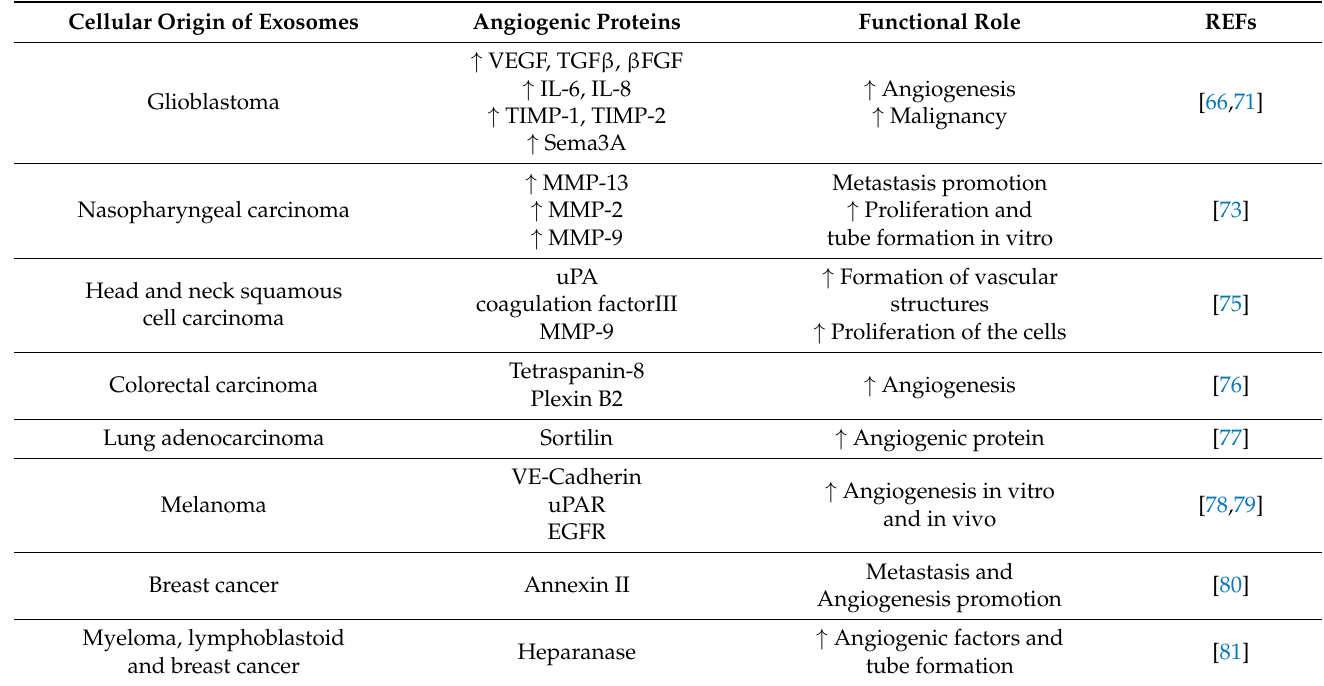
Table 1. Angiogenic proteins carried by tumor-derived exosomes and their functional roles in cancer